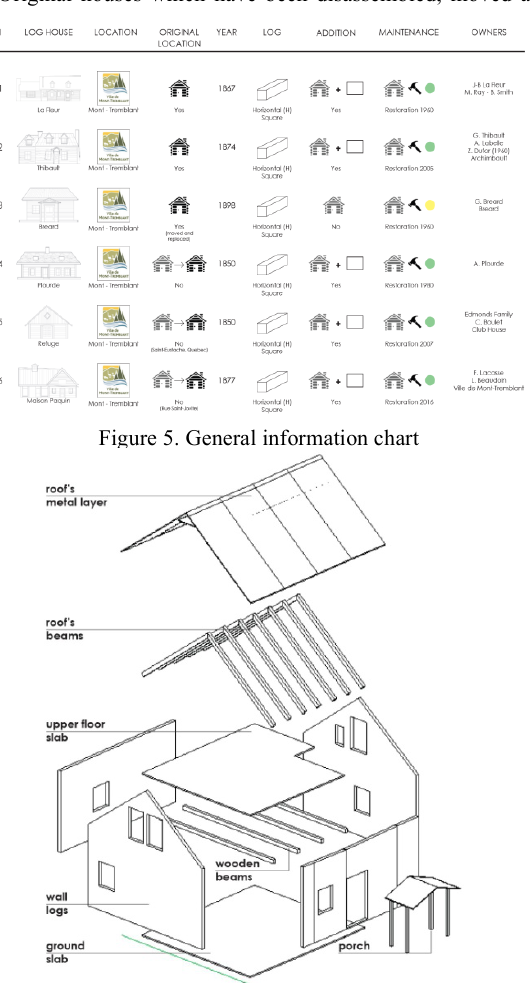
Figure 6. Breard Log House - Exploded Axonometric View